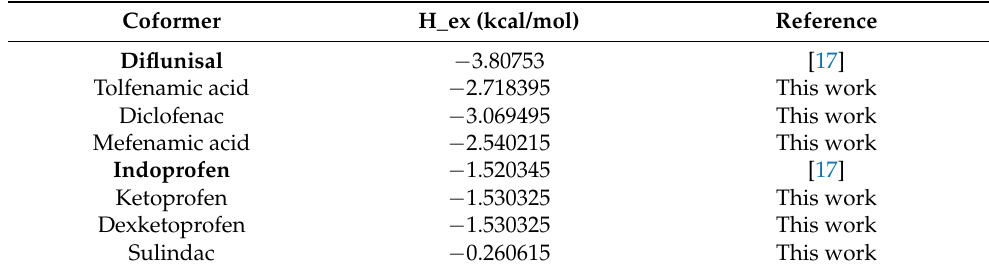
Table 2. Ranking positions for CIP coformer candidates, including the two NSAID drugs reported in CSD (in bold), based on COSMOQuick